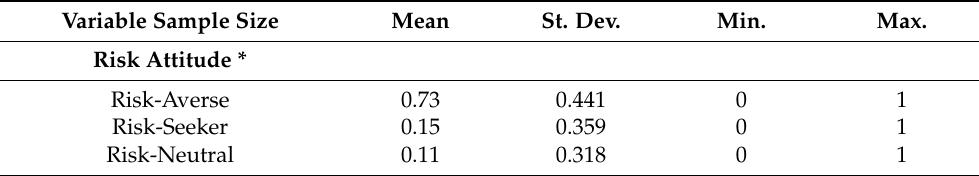
Table 6. Distribution of risk attitude of the sampled respondents. Variable Sample Size Mean St. Dev. Min. Max. Risk Attitude